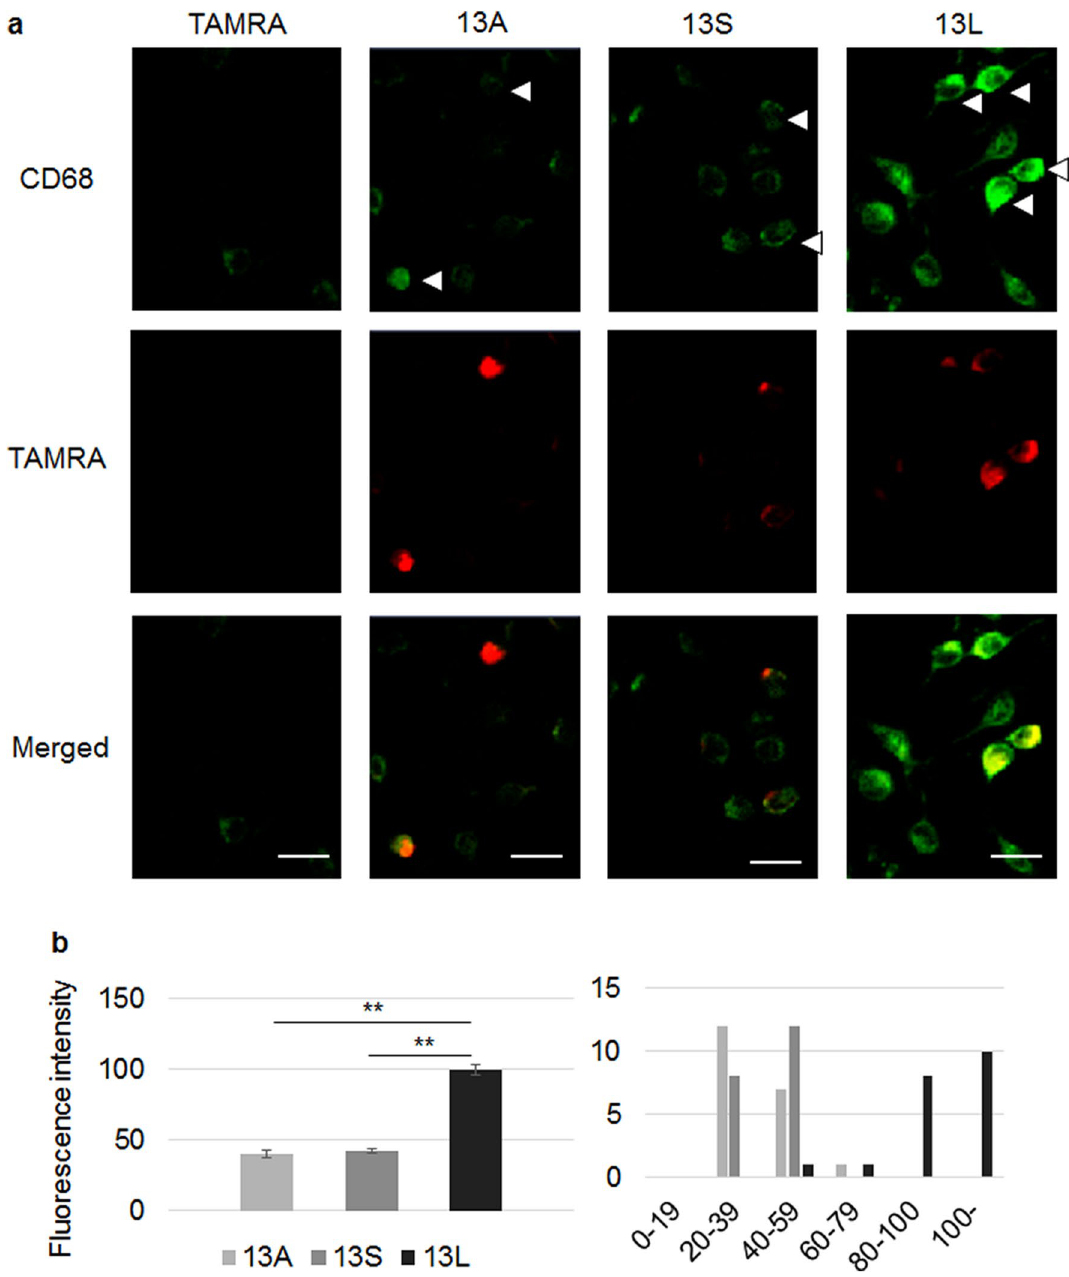
Figure 3. 13L induced high CD68 expression in BV2 microglia. ( a ) Immunofluorescence staining of BV2 cells having TAMRA, 13A, 13S or 13L (red) with anti-CD68 antibody (green). Arrowheads indicate BV2 cells having visible large aggregates. ( b ) Intensities of CD68 signals were quantified and were expressed as values relative to that of 13L-treated cells. n = 20 cells each. x-axis and y-axis of a histogram (right panel) indicate distribution of the values and numbers, respectively. Error bars represent SE. ANOVA, **p < 0.01. Scale bars 20